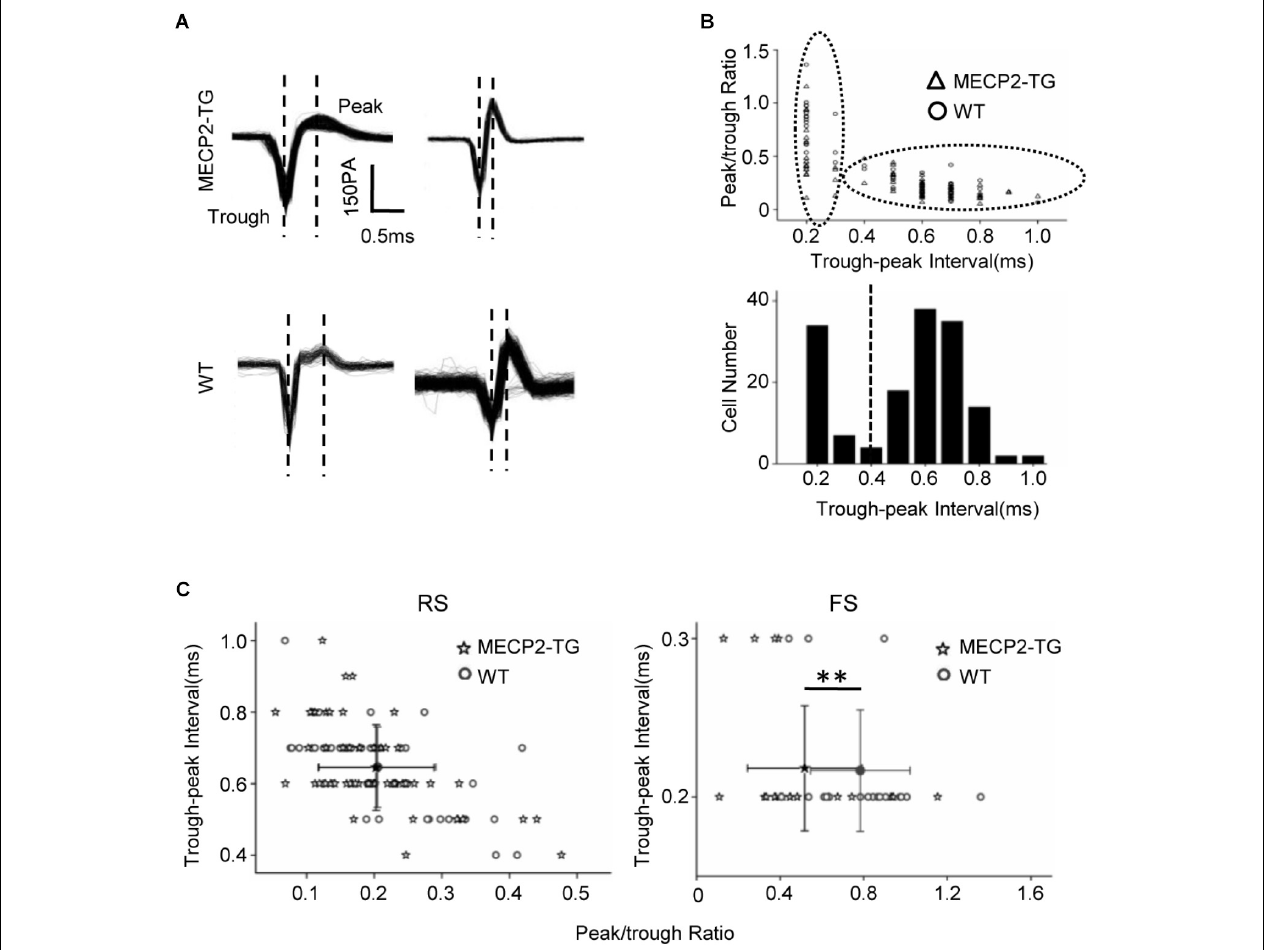
FIGURE 3 | (A) Representative spike waveforms. Dashed lines indicate the trough and peak of the spike waveform. (B) Upper panel, scatter plot of peak/trough ratios and trough-peak intervals of spike waveforms from all recorded neurons. Bottom panel, histogram of the peak-trough intervals recorded from all recorded neurons. (C) Scatter plot of the peak/trough ratio and trough-peak interval of spike waveforms from regular-spiking neurons and fast-spiking neurons, respectively. Peak/trough ratio: ∗∗ p < 0.01; t -test, mean ± standard